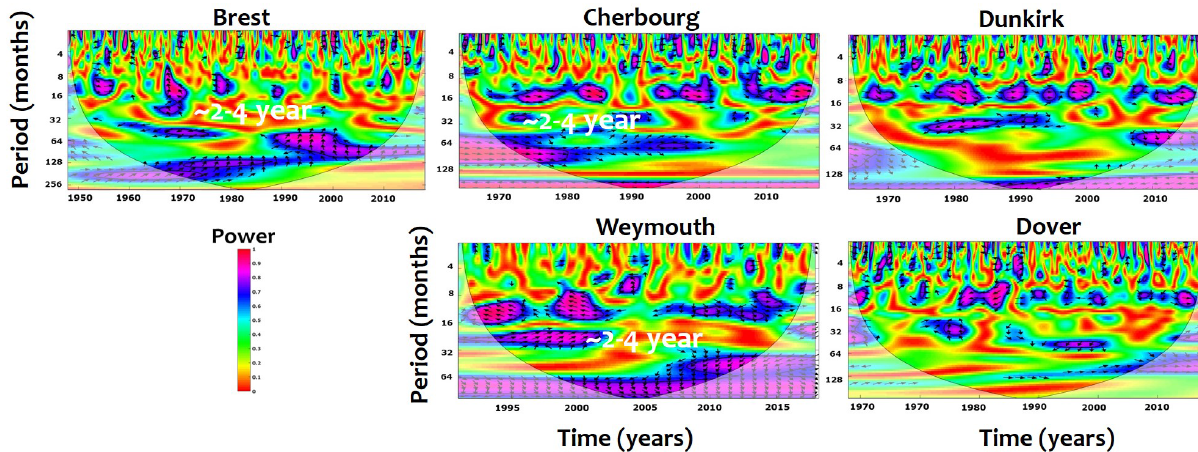
Figure 6. Cross-wavelet correlations between monthly extrema of surges and zonal wind